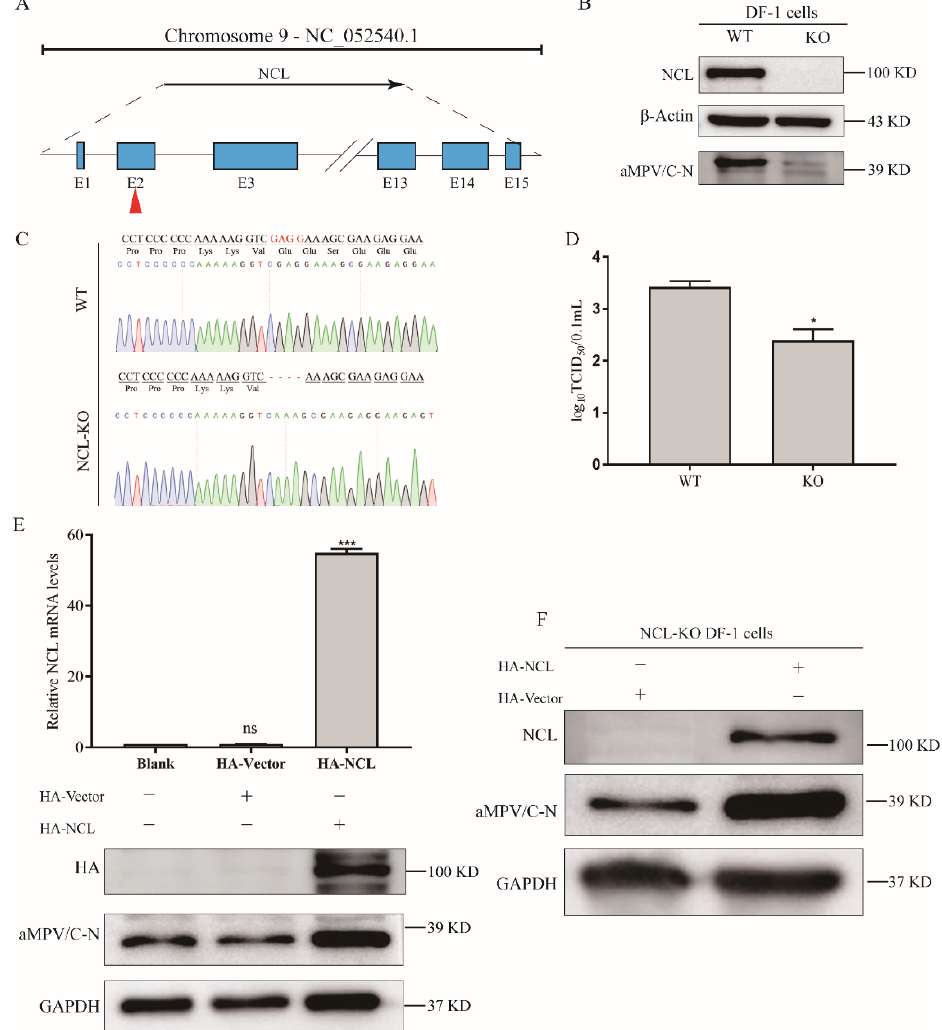
Figure 3. Knocking − out NCL limits the aMPV/C replication. ( A ) The genomic structure of chicken NCL gene and the knock − out strategy for NCL knockout using CRISPR/Cas9. NCL − KO cells and wild − type (WT) cells were infected with aMPV/C, and the cells and supernatants were collected 48 h later. Western blotting, sequence analysis, and TCID 50 assay were used to evaluate the expression of NCL and aMPV/C N ( B ), DNA sequence ( C ), and the viral titer ( D ). NCL − KO cells and WT cells transfected with pCMV − HA − NCL plasmids were infected with aMPV/C, and the cells were harvested 48 h later for analysis of the relative NCL RNA level ( E ) and of the viral protein expression level ( F ) using qRT − PCR and western blotting. β− Actin or GAPDH was used as an internal control.